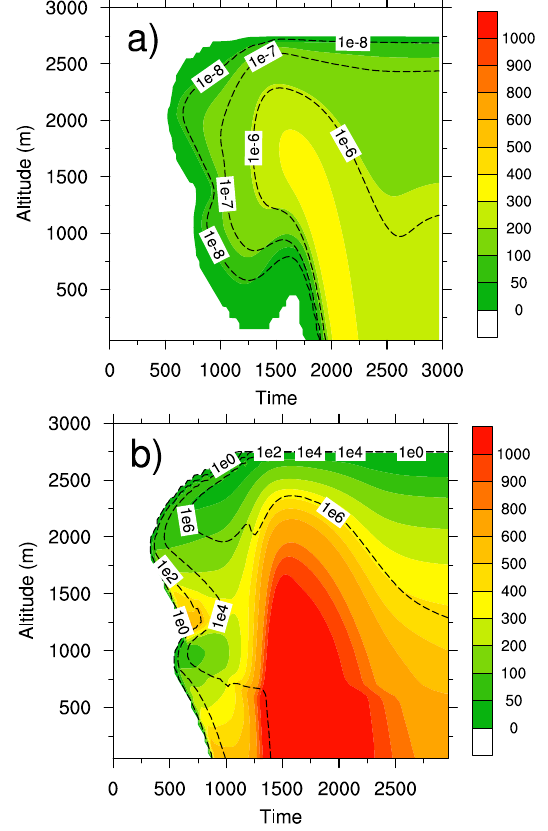
Figure 1. HaRP case: time evolution of vertical profiles at the centre of the cloud cell for 3 Fig. 1. HaRP case – time evolution of vertical profiles at the cen- tre of the cloud cell for mean raindrop radius (µm): (a) using the mean raindrop radius ( µ m): (a) using the Kessler scheme and (b) using the C2R2 scheme. For 4 Kessler scheme and (b) using the C2R2 scheme. For the Kessler the Kessler scheme (a), the rain liquid water content (vol/vol) is superimposed as isolines. For 5 scheme (a) , the rain liquid water content (volvol − 1 ) is superim- posed as isolines. For the C2R2 scheme (b ), the number concentra- the C2R2 scheme (b), the number concentration of raindrops (L-1) is superimposed as 6 tion of raindrops (L − 1 ) is superimposed as isolines. isolines. 7